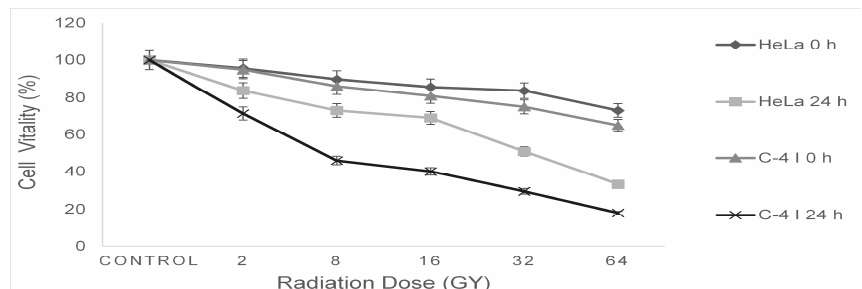
Figure 1. Effect of gamma radiation on survival of C-4 I and HeLa cells at 0 to 24 h post-irradiation